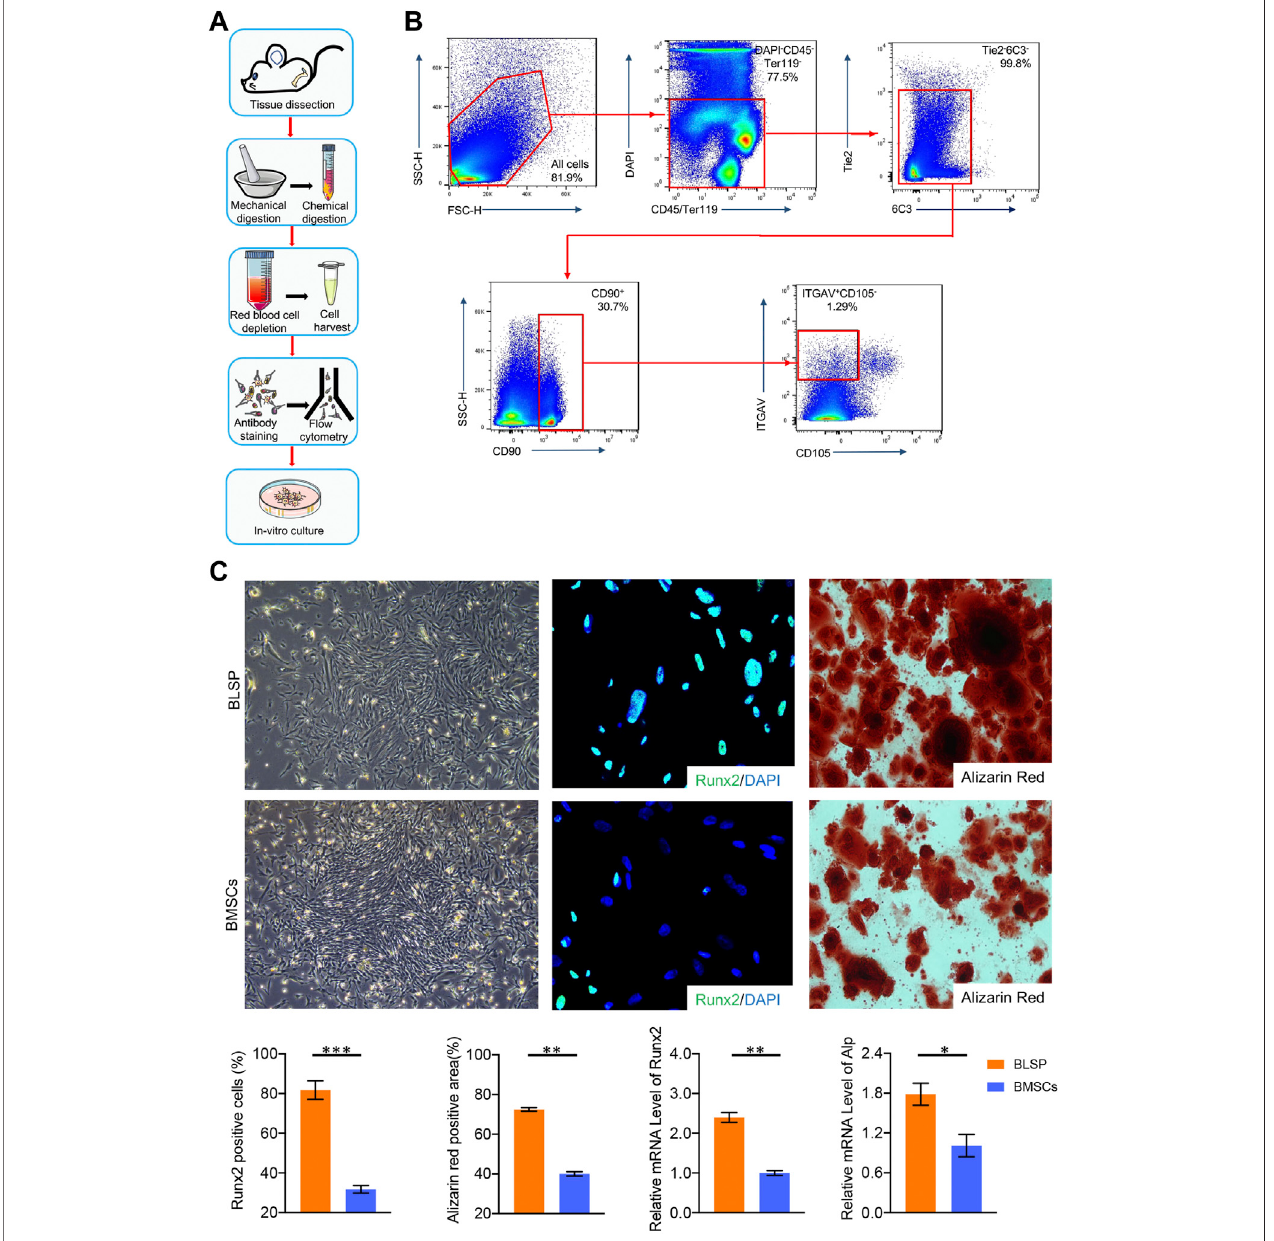
FIGURE 1 | (A) Protocol for BLSP isolation, including the isolation of the mouse skeleton by tissue dissection, dissociation of the skeleton into a single-cell suspension by mechanical and chemical digestion, depletion of red blood cells with ACK lysis buffer, antibody staining of the BLSP, and sorting of the BLSP on a fl ow cytometer, BLSP culture. (B) Gating strategy used to sort the BLSP. Representative FACS plots with the percentage of the parent gate for BLSP. (C) Colony formation abilityandosteogenicpotentialbetweenBLSPandBMSCs. n =4foreachgroup.Dataareshowedasmeans±standarddeviation(* p < 0.05,** p < 0.01,and*** p <